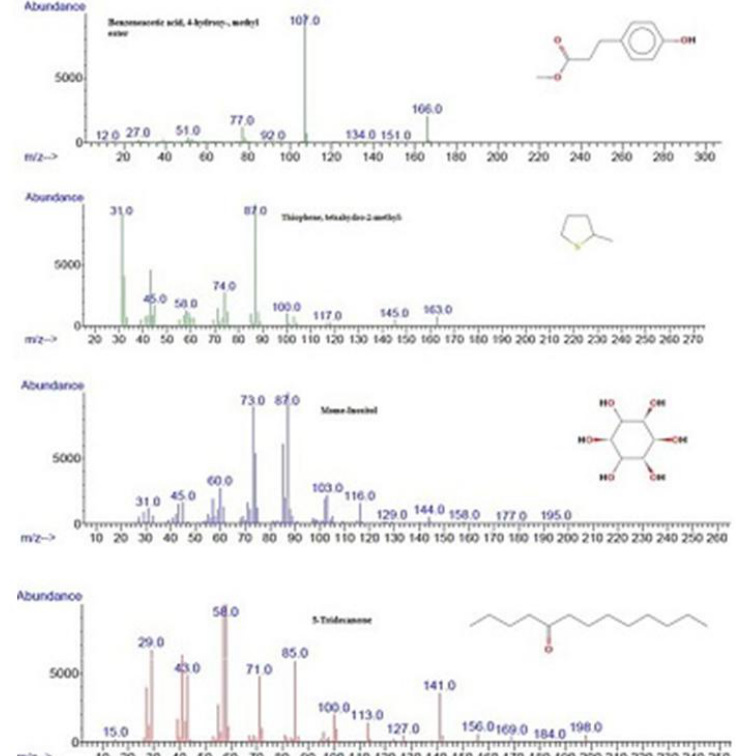
Fig. 2: Mass spectrum and structure of active phytocomponents identified by GC-MS in extract of G.